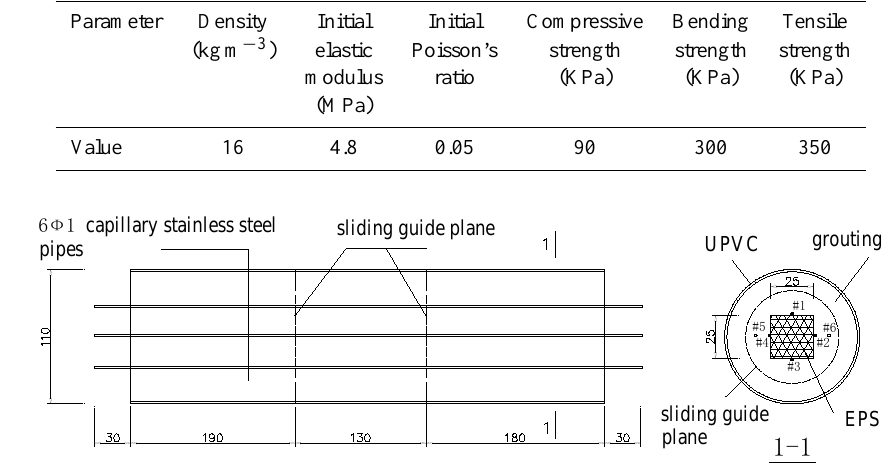
Fig. 1 Double shearing test model (unit: mm)